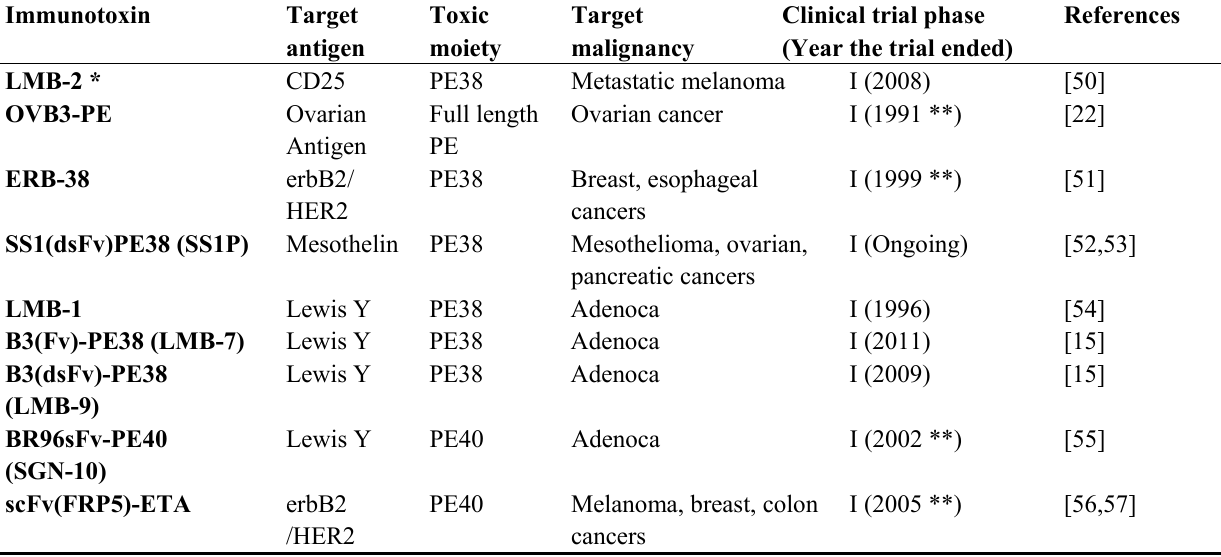
Table 2. Clinically evaluated/under evaluation PE-based immunotoxins against solid